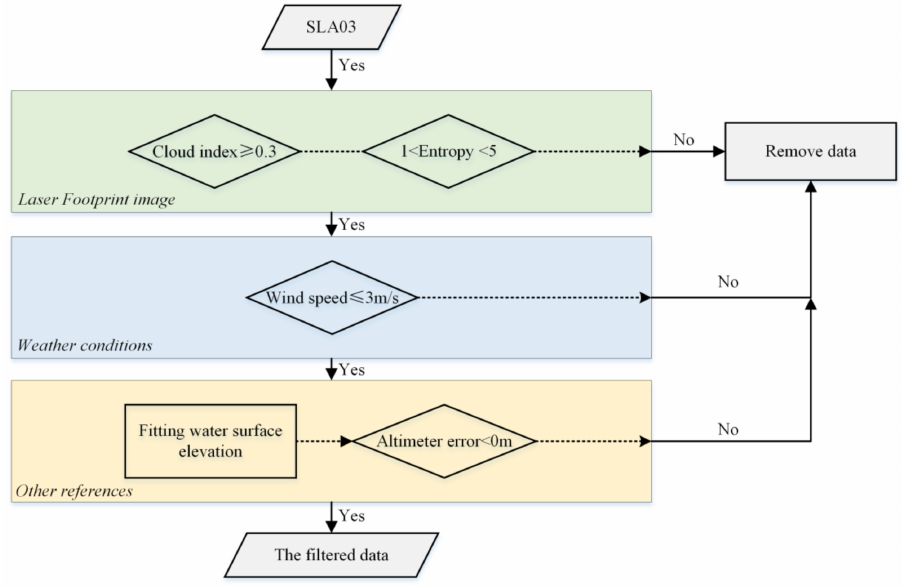
Figure 12. Atmospheric scattering identification process for water